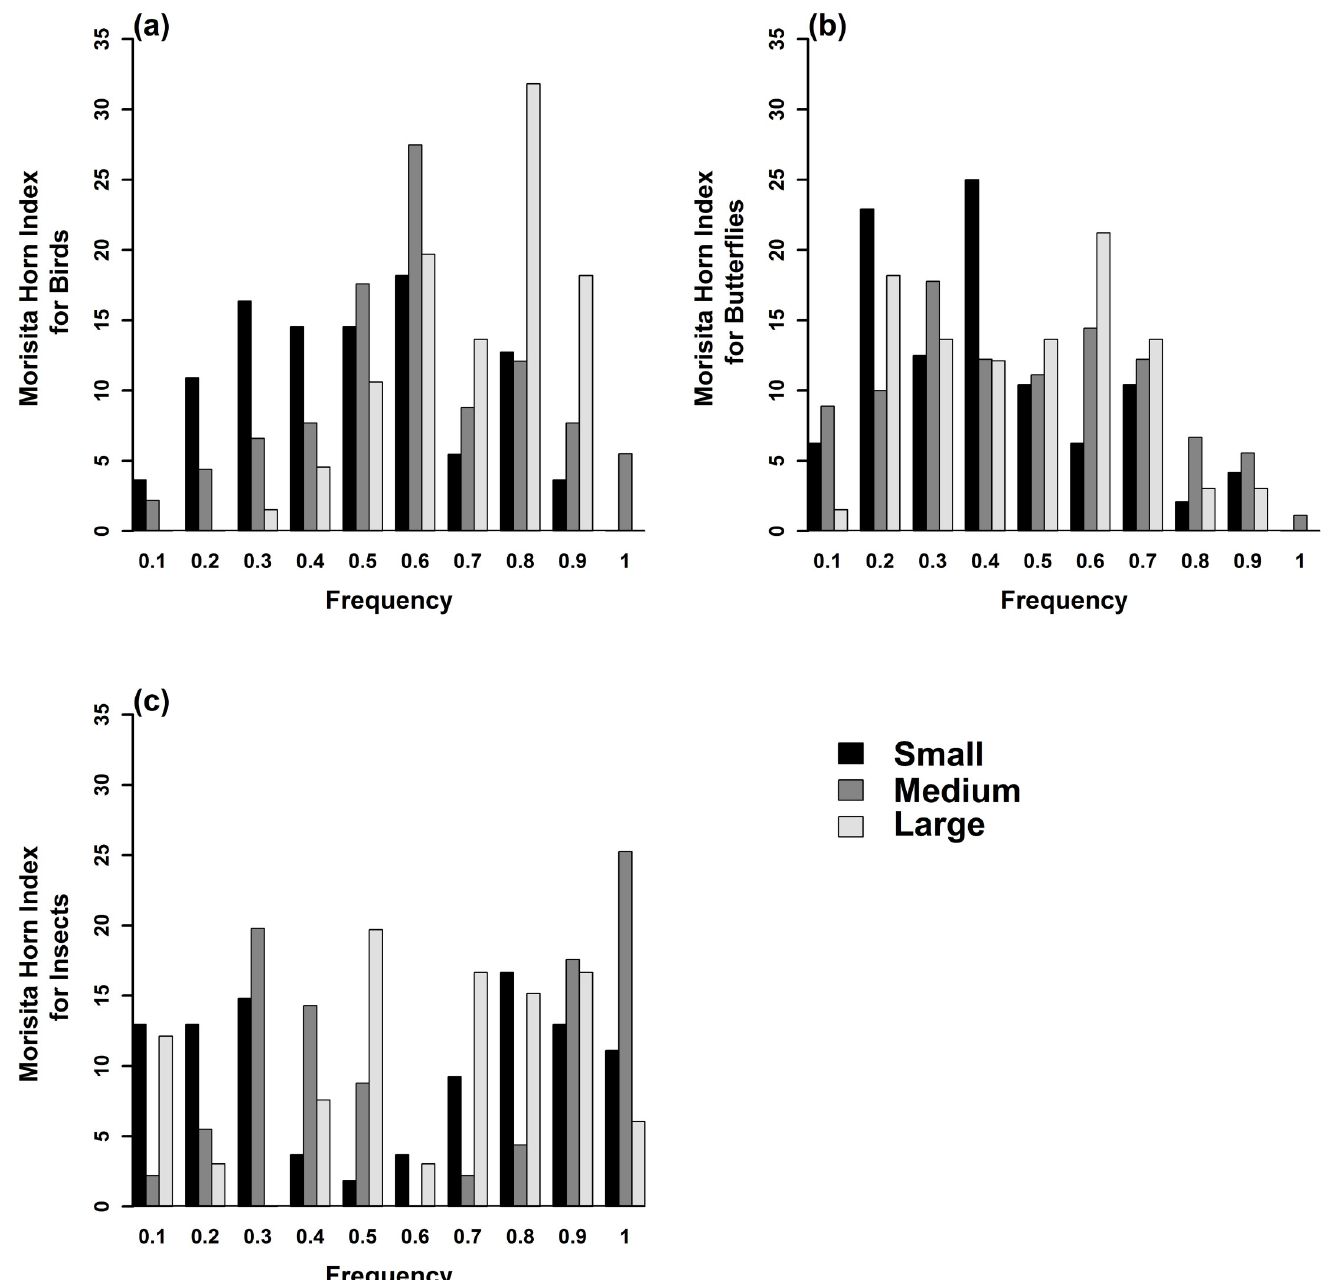
Fig 4. Frequency distribution of Morisita-Horn index values across size class of NPs: (a) Birds; (b) Butterflies and (c) Insects.